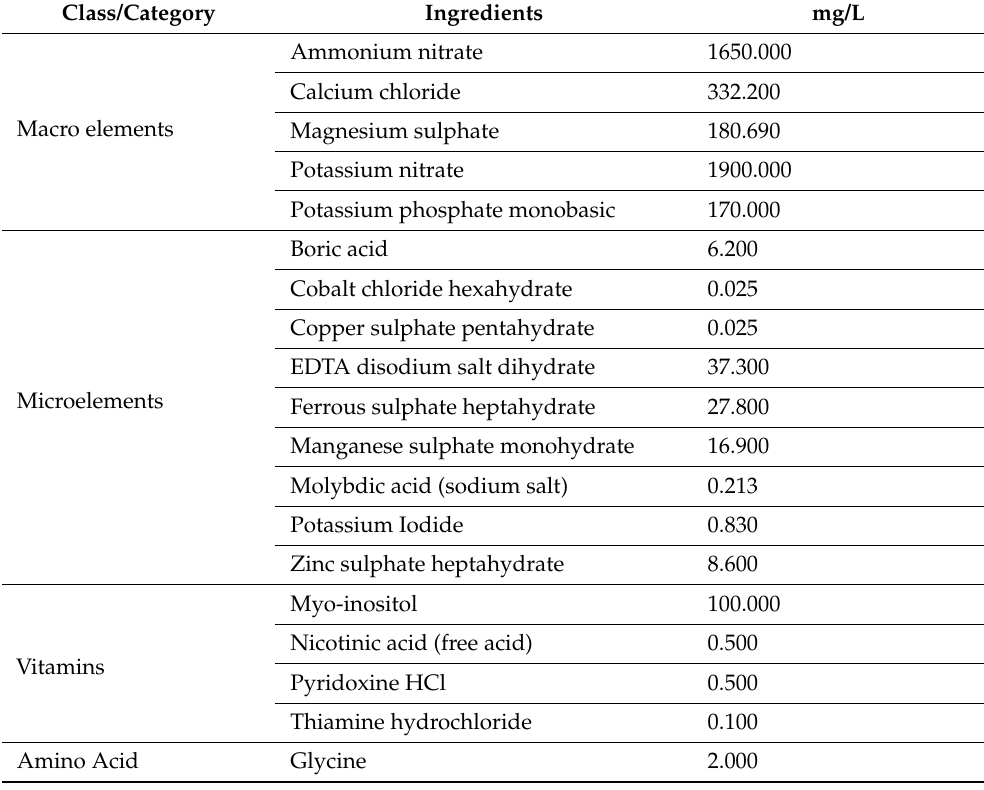
Table 1. Composition of MS nutrient media used for the growth of A. thaliana